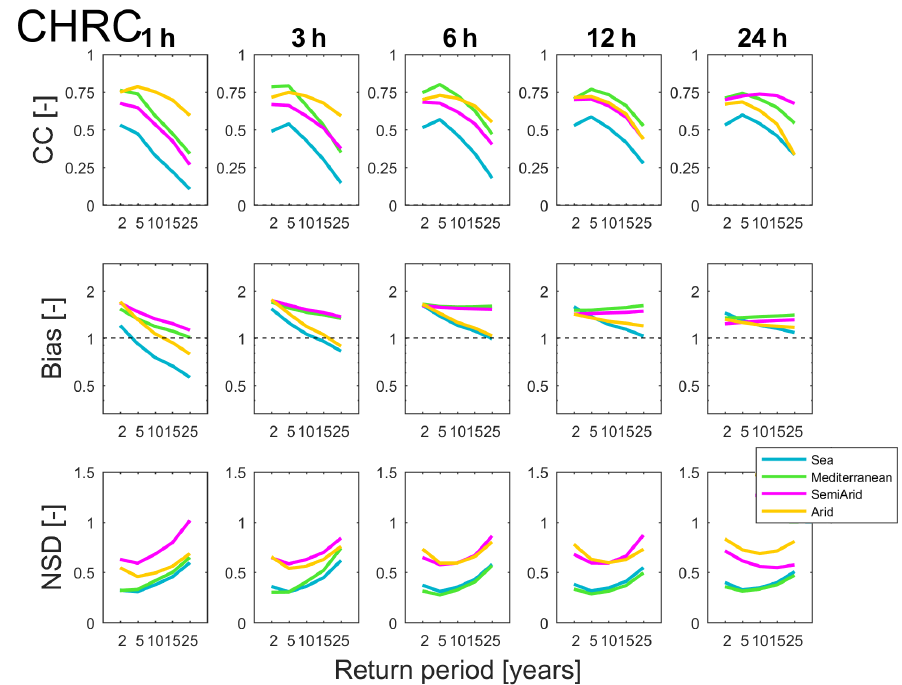
Figure 8. Comparison of IDF values between CHRC and radar for different climatic regions. Blue lines represent sea areas while green, pink, and orange lines represent the Mediterranean, semiarid, and arid climates respectively. The upper row of panels shows the CC for different durations, the middle row the bias, and the lower row the